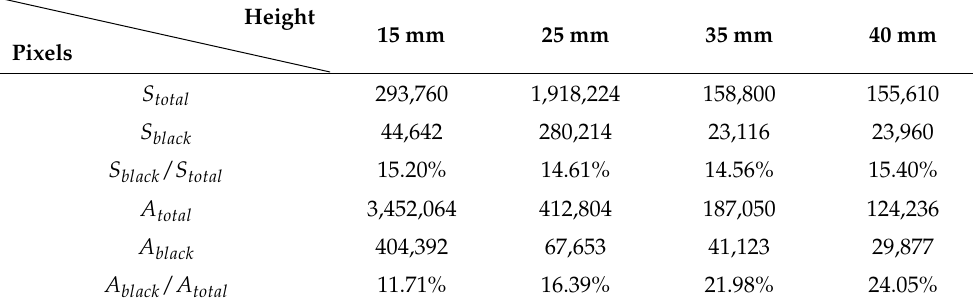
Figure 10. Infill density at a different height (S denotes uniform filling structure, and A denotes adaptive-density filling structure) . It was evident that an adaptive-density filling structure based on the Hilbert curve was generated for 3D-printed components with variable sections, and each slice was filled with a Hilbert curve at the same level, but the side lengths of the Hilbert curve is